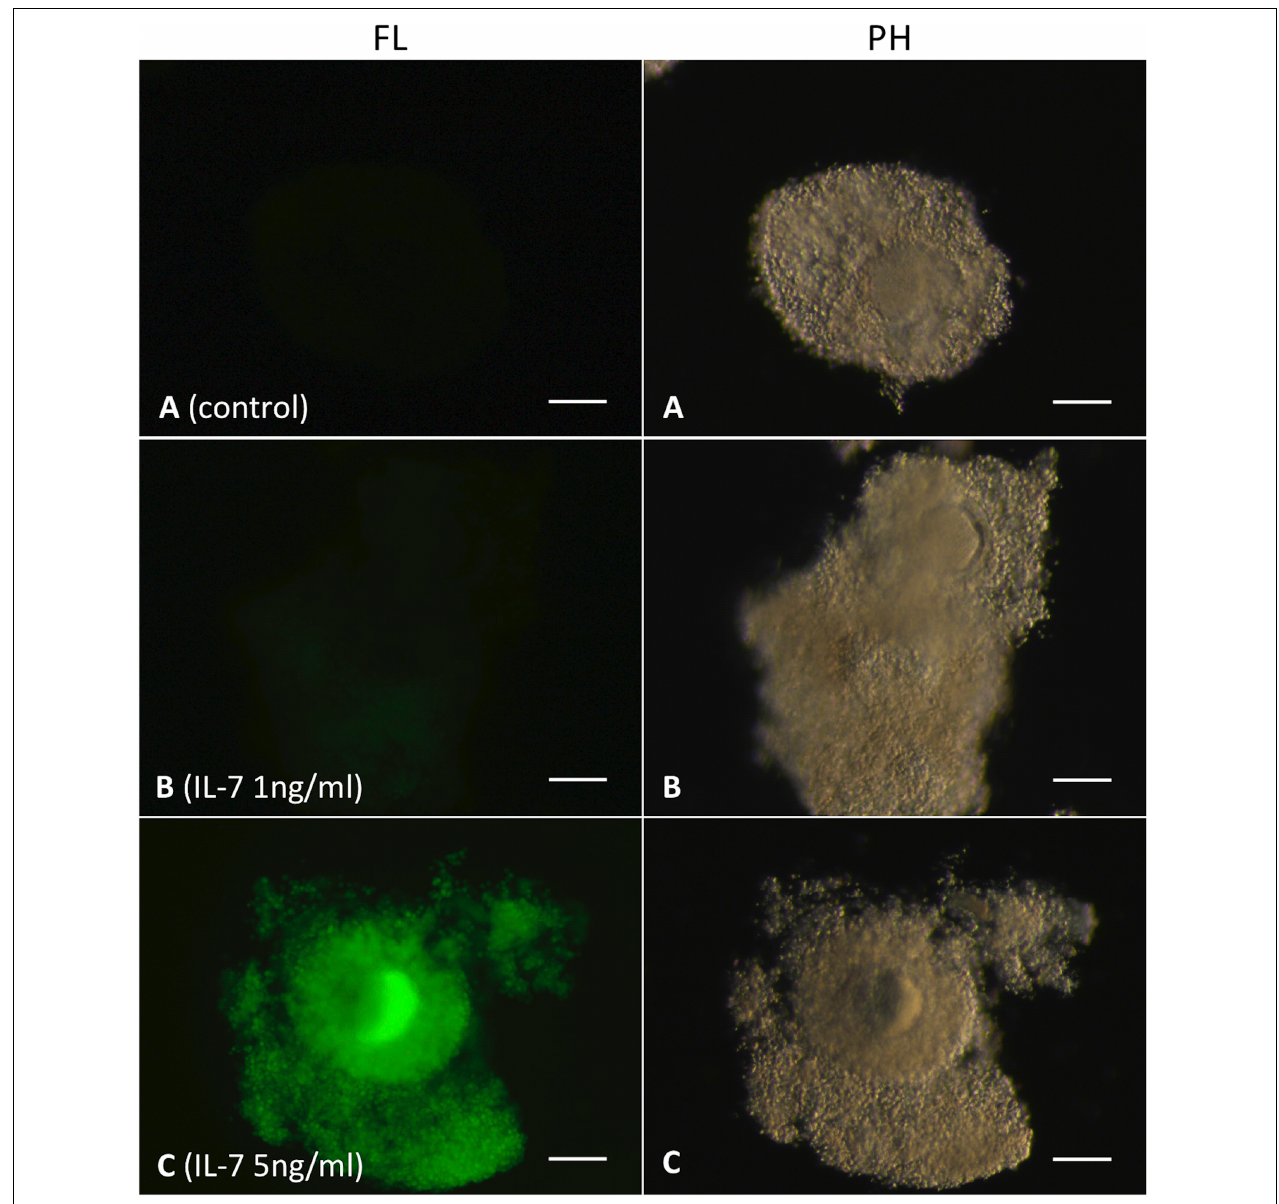
FIGURE 5 | Assessment of intracellular ROS in cumulus-oocyte complexes (COC) based on 2 (cid:48) , 7 (cid:48) -dichlorodihydrofluorescein diacetate (DCFH-DA) staining. Ovine COC were matured in vitro without (control) or with IL-7 (1 or 5 ng/ml) supplementation and stained with DCFH-DA. The green color DCF fluorescence represents ROS. (A) COC, control group; (B,C) COC, IL-7 supplemented groups. Five COC were assessed in each experimental group. FL, fluorescence image; PH, phase-contrast image. Scale bar = 100 µ